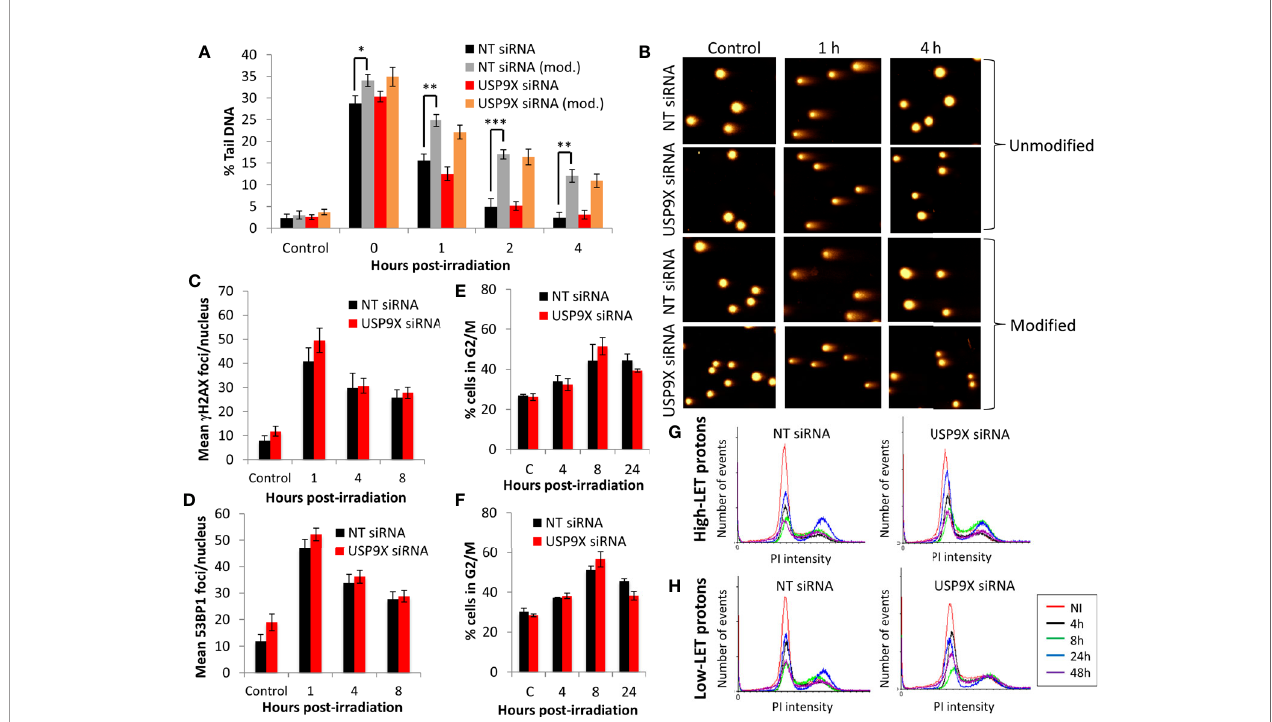
FIGURE 4 | USP9X depletion does not affect the repair of CDD or cell cycle progression in response to relatively high-LET protons. HeLa cells were treated with USP9X or a non-targeting (NT) control siRNA for 48 h. (A) Cells were irradiated with 4 Gy relatively high-LET protons, and DNA damage measured at various time points post-irradiation using the enzyme-modi fi ed neutral comet assay in the absence (revealing DSBs) or presence (revealing CDD; as indicated by mod) of the recombinant enzymes APE1, NTH1, and OGG1. Shown is the mean percentage tail DNA ± S.D plus (B) representative images of comets. *p < 0.02, **p < 0.005, ***p < 0.002 as analyzed by a one-sample t -test. (C) g H2AX or (D) 53BP1 foci were analyzed by immuno fl uorescence staining at various time points post-irradiation. Shown is the mean number of foci/nucleus ± S.D. (E – H) Cell cycle pro fi les were determined by fl ow cytometry analysis post-irradiation with (E, G) high-LET or (F, H) low-LET protons. C refers to control, unirradiated cells. (E, F) Shown is the mean percentage of cells in G2/M phase ±